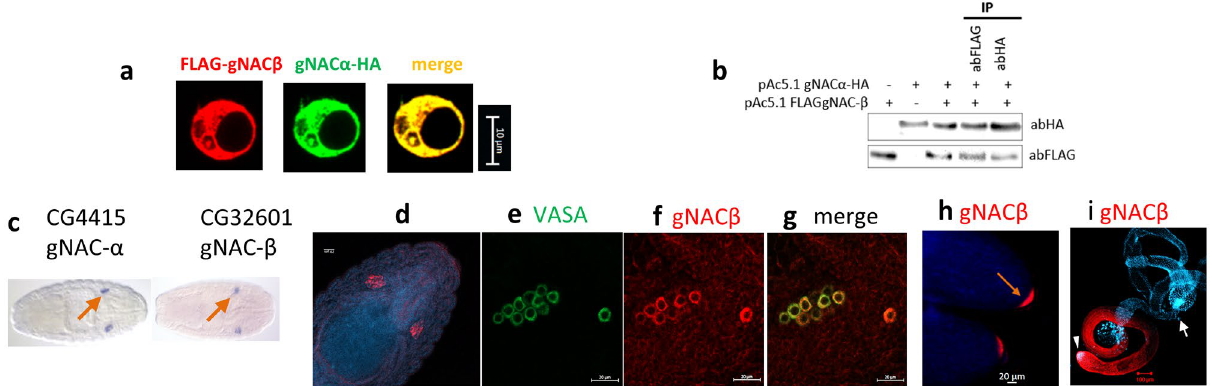
Figure 1. Detection of gNAC-α/gNAC-β heterodimer in S2 cells and gNAC-β in embryos. ( a ) Transfecting S2 cells to express pAc5.1 gNAC-αHA and pAc5.1 FLAGgNAC-β plasmids encoding the corresponding NAC subunits. ( b ) Generation and detection of gNAC after Western-blot analysis of heterodimers immunoprecipitated by abFLAG and abHA and detected using the same abs. ( c ) FISH-hybridization to detect CG4415 and CG32601 genes expression in the 14th stage embryos (from BDGP in situ homepage, https:// insitu. fruit fly. org). ( d ) gNACβ immunostaining of primordial gonads; ( e–g ) migrating primordial gonadal cells, VASA (germ cell marker) and gNACβ colocalization. ( h ) Oocytes, late stages of oogenesis, gNAC-β accumulation at the posterior poles of oocytes (arrow). ( i ) Strong staining of testis spermatocyte, gNAC-unstained somatic accessory gland (DAPI stained, arrow) and testis tip (arrowhead). Original blots for ( b ) in Expanded file 1 in